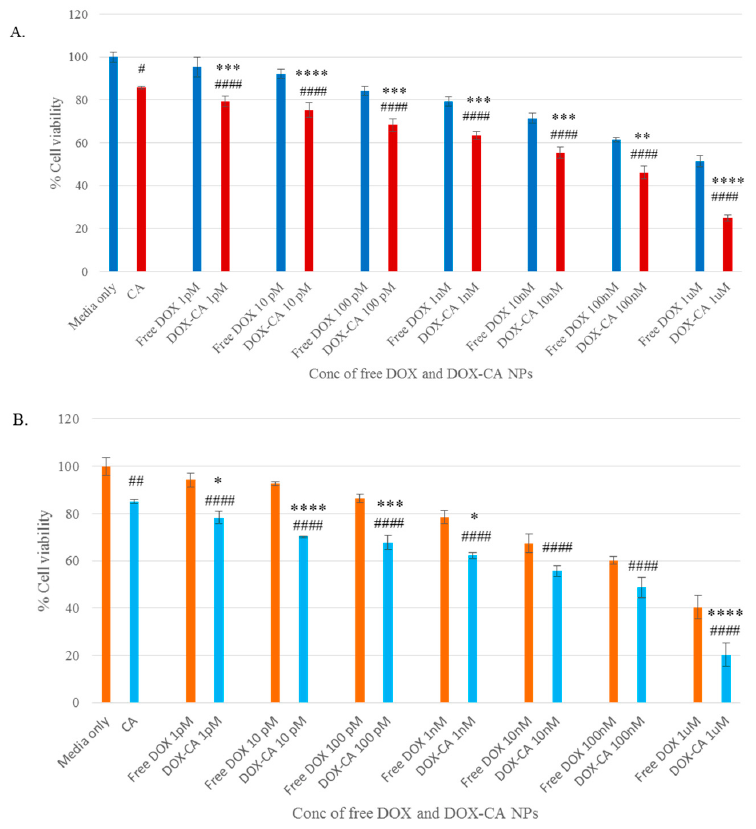
Figure 6. Cytotoxicity assay of DOX-loaded CA NPs. ( A ) cell viability assessment by MTT assay after 48 h incubation of the free DOX and DOX-loaded CA NPs with MCF-7 cell line; ( B ) cell viability assessment by MTT assay after 48 h incubation of the free DOX and DOX-loaded CA NPs with 4T1 cell line. Values were significant (*) at p -value 0.01 to 0.05, very significant (**) at p -value 0.001 to 0.01, highly significant (***) at p -value 0.0001 to 0.001, extremely significant (****) at p -value < 0.0001 vs. same treatment of free DOX. Values were significant (#) at p -value 0.01 to 0.05, very significant (##) at p -value 0.001 to 0.01, highly significant (###) at p -value 0.0001 to 0.001, extremely significant (####) at p -value < 0.0001 vs. untreated cells at CI of 95%.